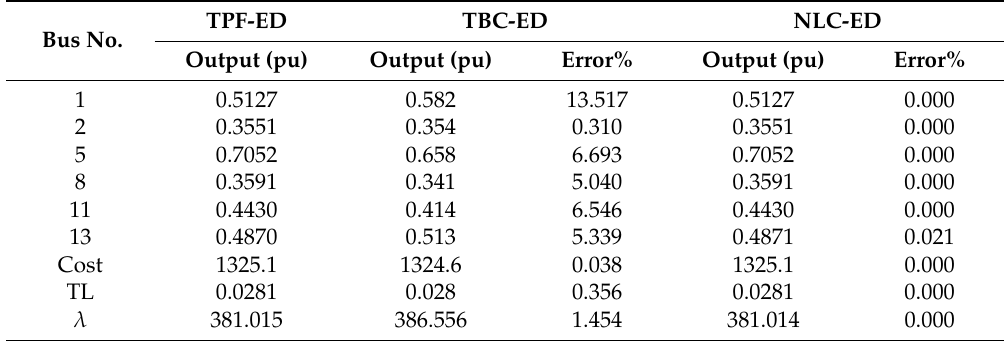
Table 9. ED simulation results compared with traditional ED and new loss coefficients of the IEEE 30-bus system under the base case system demand